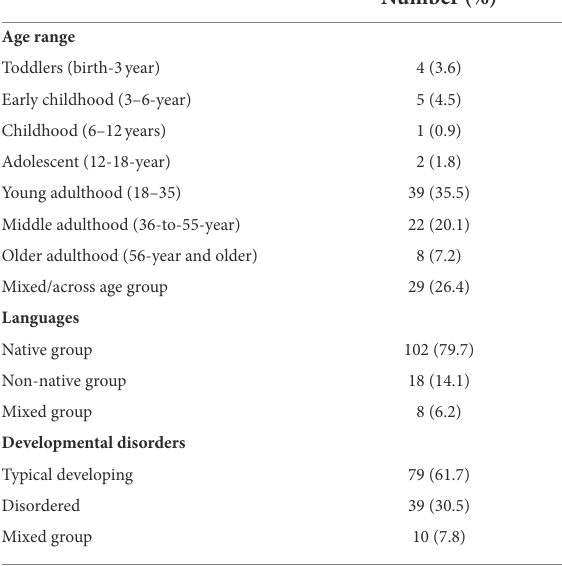
TABLE 2 Summary of the demographic information of participants in reviewed